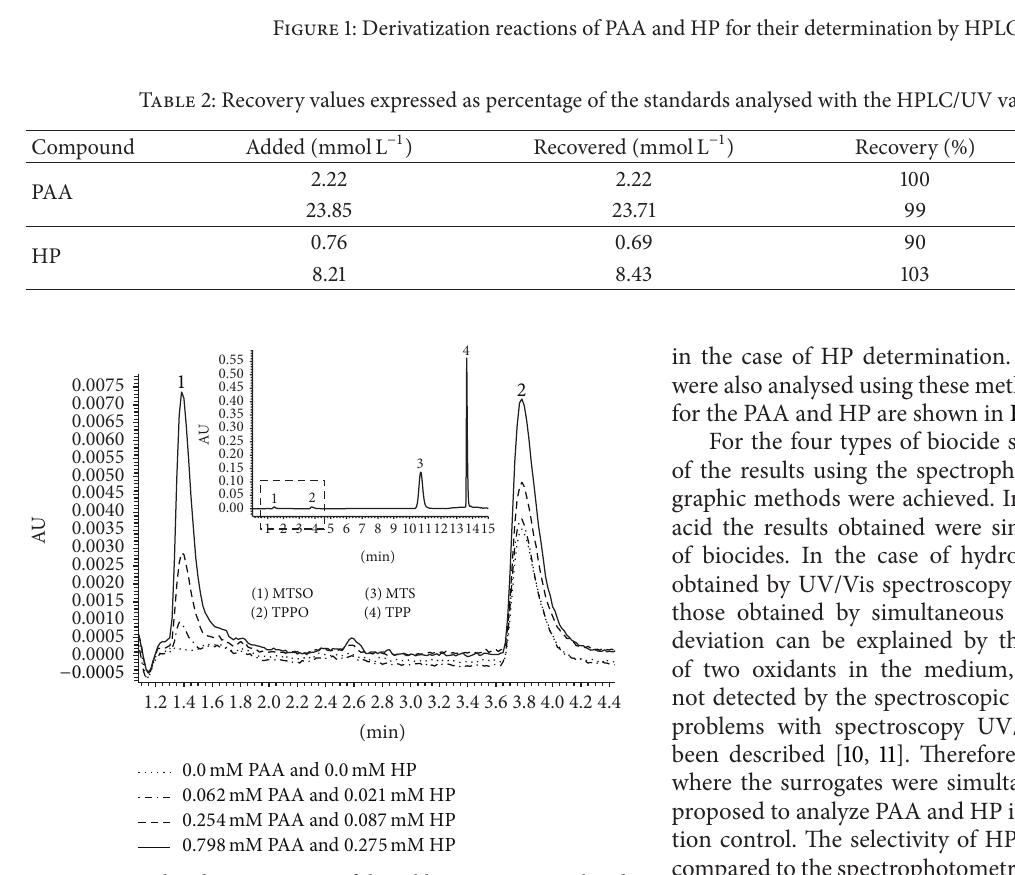
Figure 2: Overlay chromatograms of the calibration curve analysed by